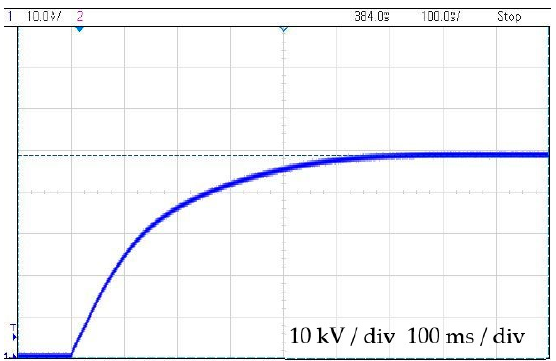
Figure 12. Rise of the output voltage from zero to nominal 50 kV without any external load.